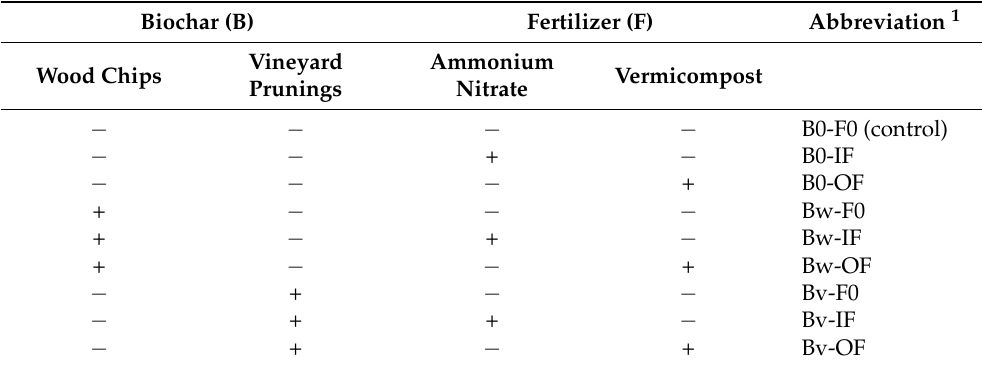
Table 1. Treatment combinations used in the experiment. Biochar (B) Fertilizer